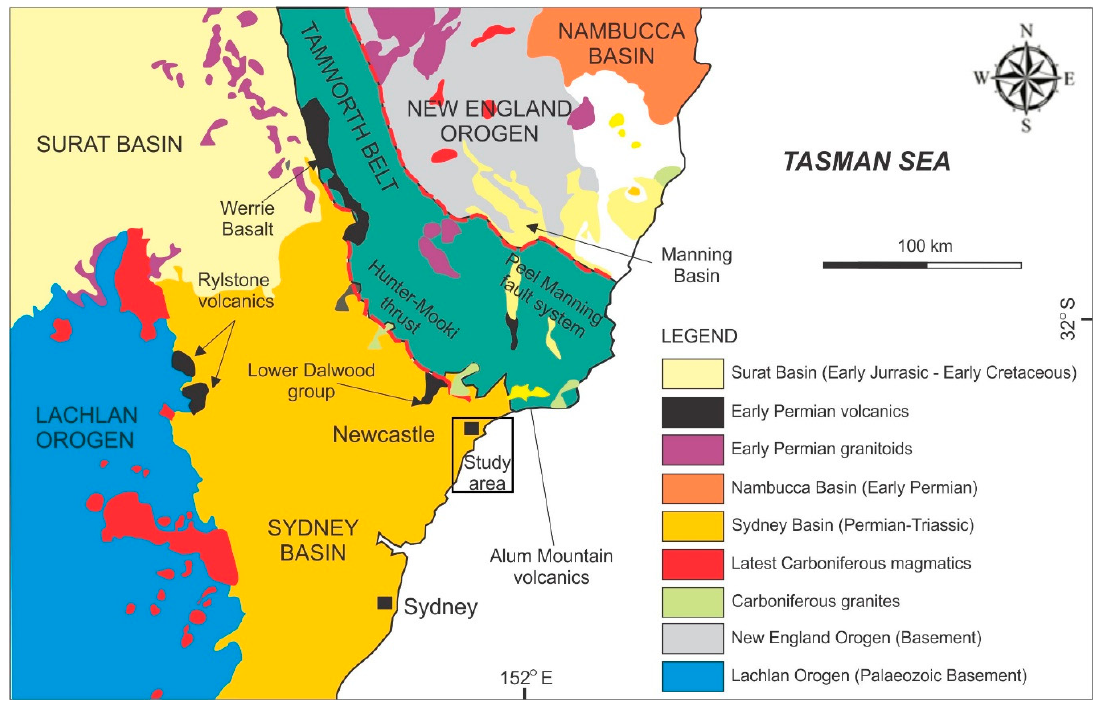
Figure 1. Geological map of the study area (Sydney Basin) and surrounding regions including the New England and Lachlan Orogens and adjacent sedimentary basins [19,20].